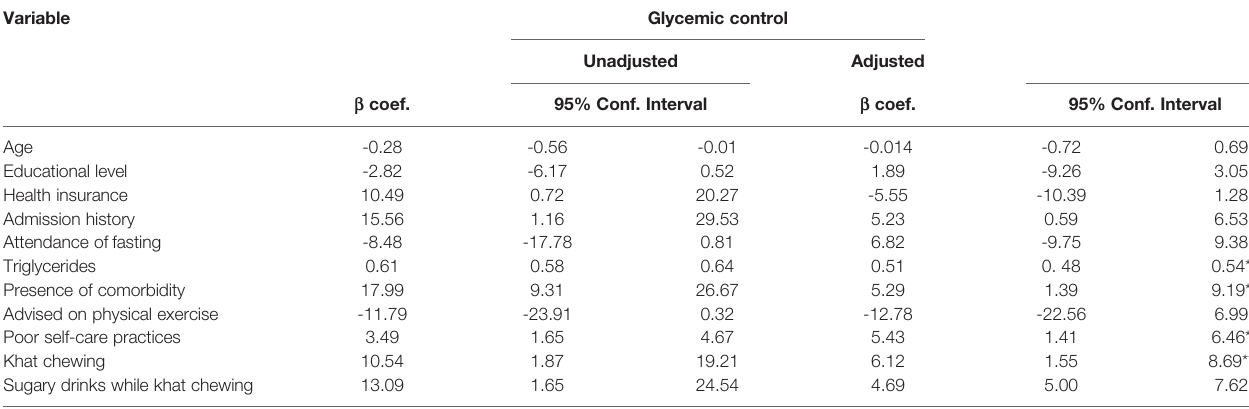
TABLE 4 | Correlates of glycemic control among patients with T2D in Eastern Ethiopia, 2020/2021 (n = 879). Variable Glycemic control